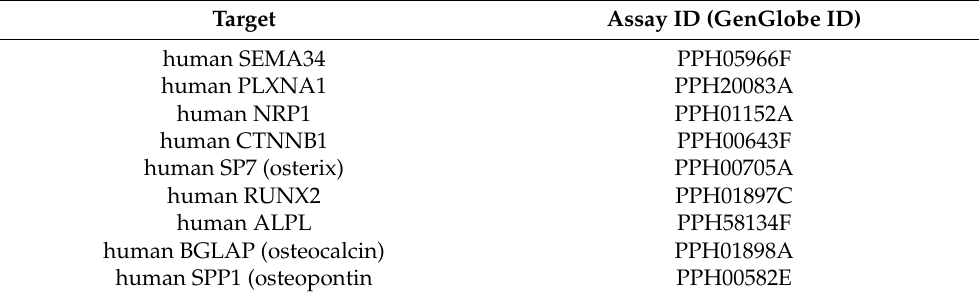
Table 1. Quantitative PCR Primer